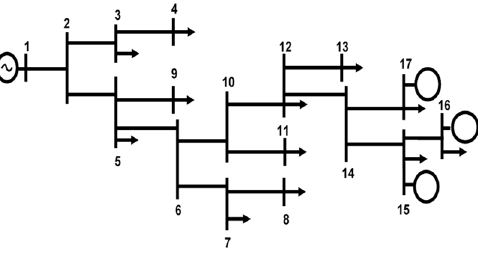
Figure 2. Seventeen-node test distribution feeder.